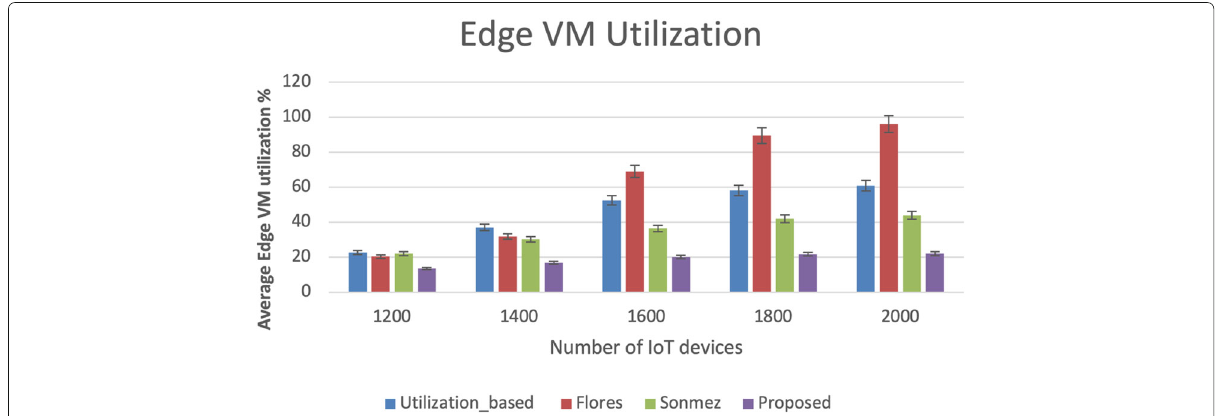
Fig. 14 Edge server utilization of the proposed approach with other related approaches part 2